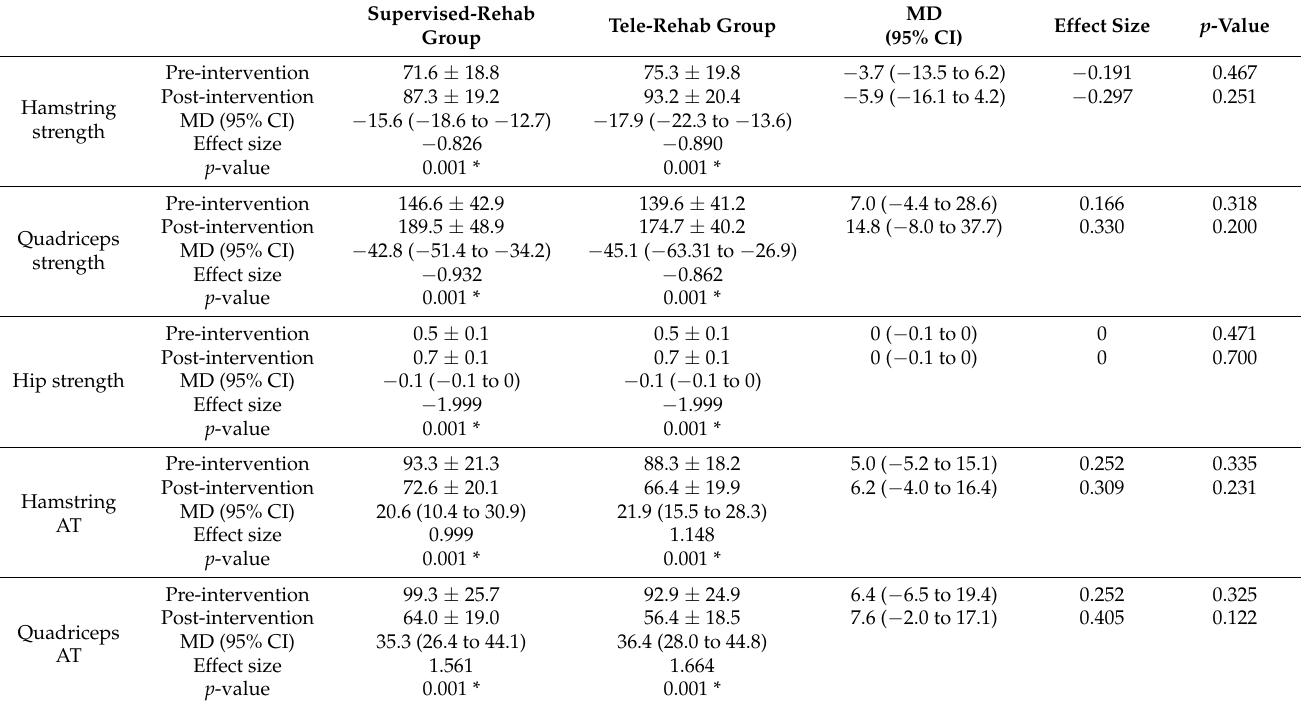
Table 2. Comparison of the muscle strength and muscle activation time in the supervised-rehab and tele-rehab